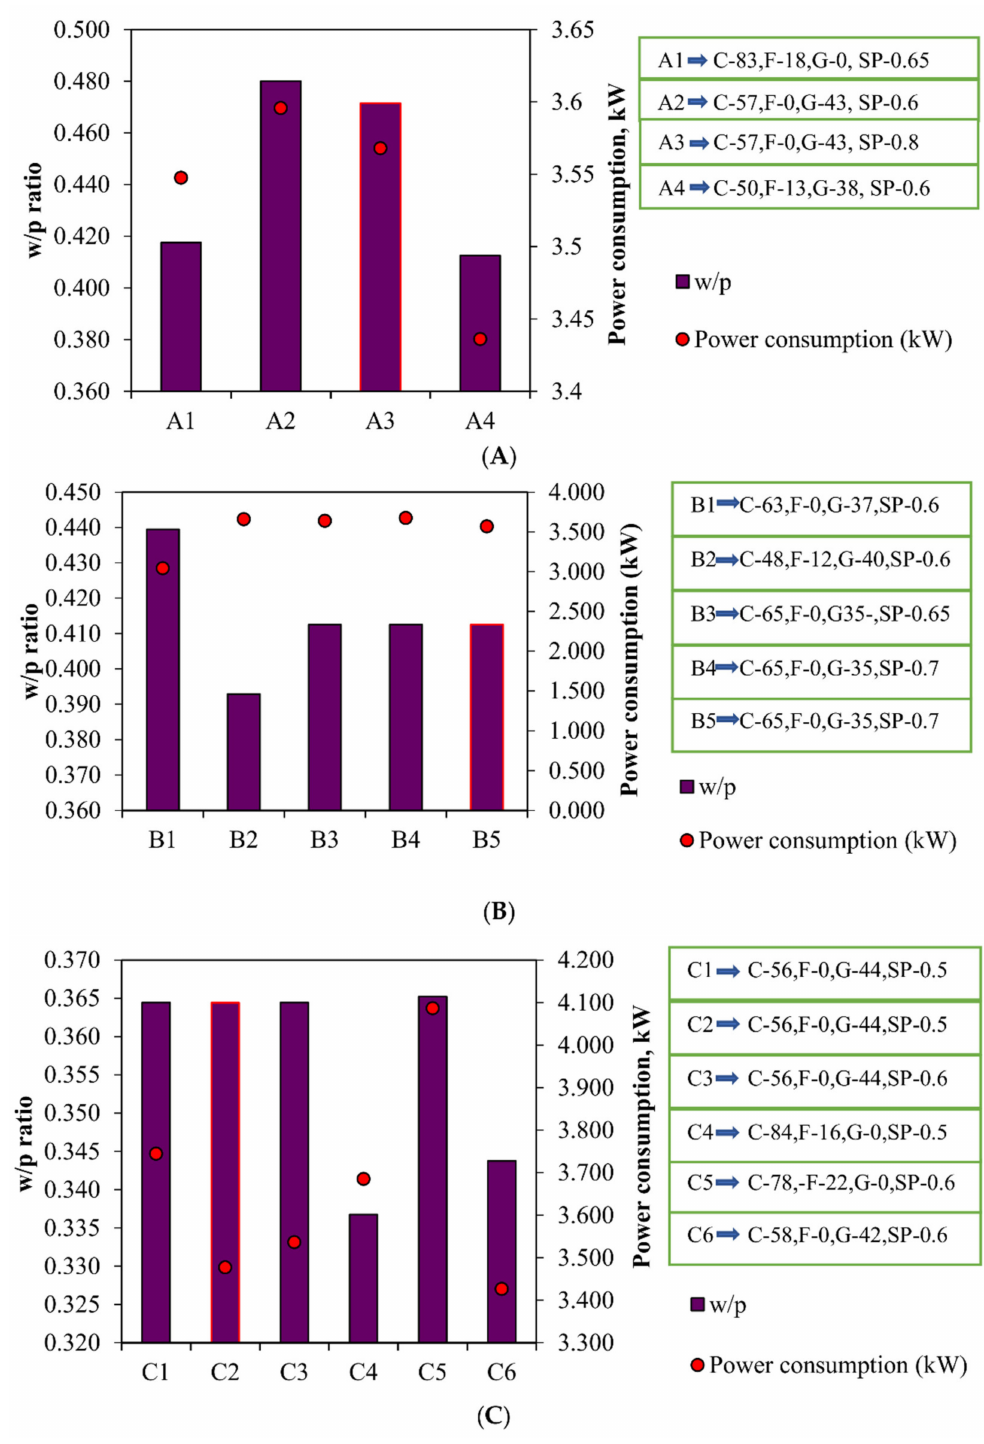
Figure 12. Power consumption versus w/p ratio for ( A ) M25 grade concrete, ( B ) M30 grade, ( C ) M40 grade concrete. C—Cement, F—Fly ash, G—GGBS, SP—Superplasticizer. A3, B5,